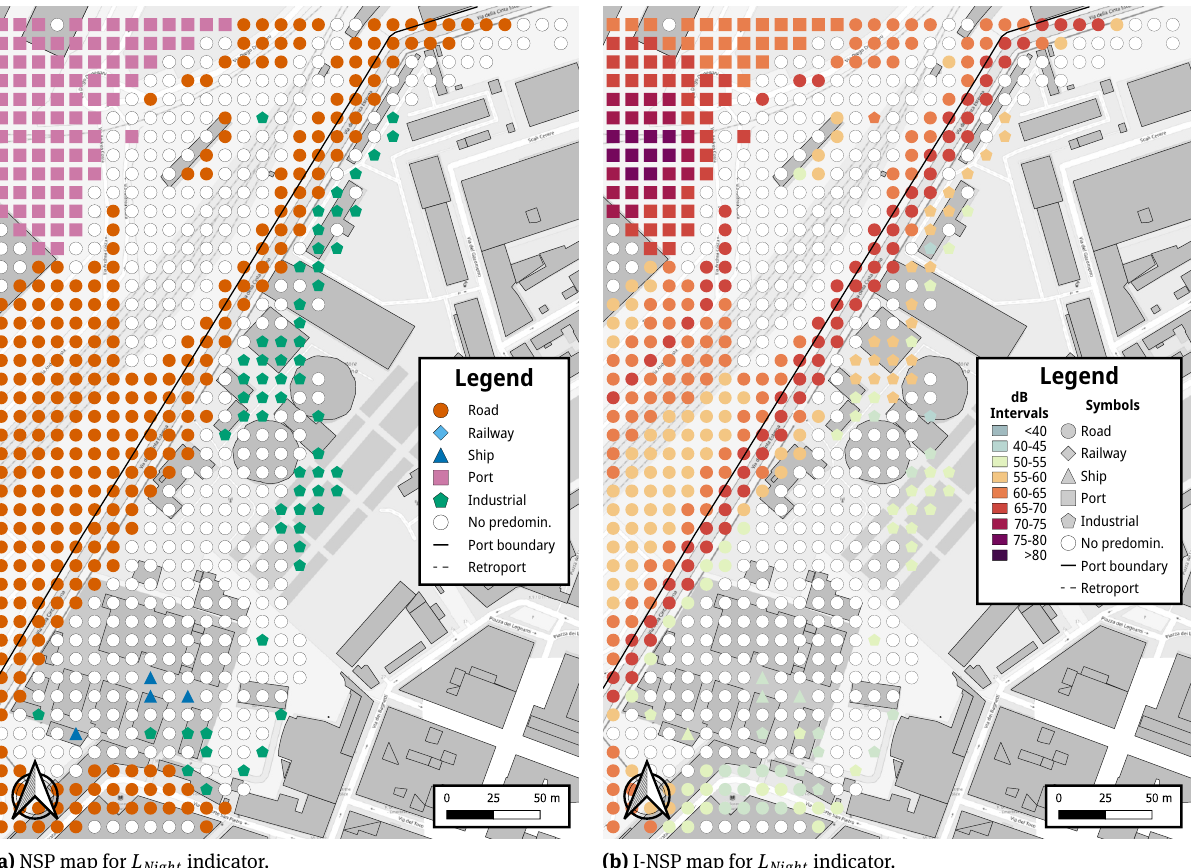
Figure 7: NSP and I-NSP maps of the central section of the port of Livorno for L Night indicator which shown ship and industrial noise pre- dominance outsides the port